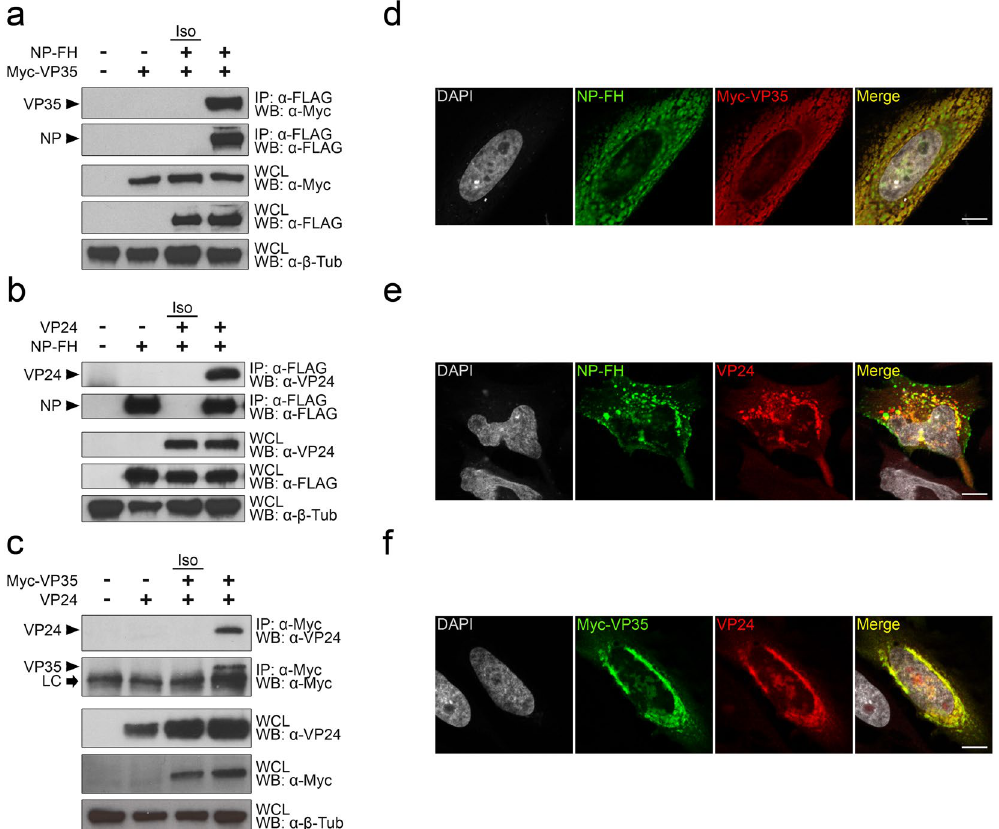
Figure 1. NP, VP35, and VP24 interact independently with each other. ( a – c ) HEK 293 cells were co-transfected with pCAGGS-NP-FH and pCAGGS-Myc-VP35 ( a ), pCAGGS-NP-FH and pCAGGS-VP24 ( b ), or pCAGGS- Myc-VP35 and pCAGGS-VP24 ( c ). Lysates were immunoprecipitated with mouse anti-FLAG ( a , b ), mouse anti-Myc ( c ), or isotype control (Iso; a , b ) antibodies, and immunoprecipitation (IP) and whole cell lysate (WCL) fractions were subjected to Western blot (WB) with mouse anti-FLAG, mouse anti-Myc, rabbit anti-VP24, and rabbit anti- β -tubulin antibodies. The precipitated proteins in the IP fraction are labeled with arrowheads, and the light chain (LC) of the mouse anti-Myc antibody is indicated with an arrow ( a , b ). IP/Western blot data are representative of at least three independent experiments. Western blots were cropped for presentation; full-length blots are available in Supplementary Fig. 6. ( d – f ) Hela cells were co-transfected with pCAGGS- NP-FH and pCAGGS-Myc-VP35 ( d ), pCAGGS-NP-FH and pCAGGS-VP24 ( e ), or pCAGGS-Myc-VP35 and pCAGGS-VP24 ( f ). Following fixation and permeabilization, cells were stained with rabbit anti-FLAG ( d ), mouse anti-FLAG ( e ), mouse anti-Myc ( d , f ), and/or rabbit anti-VP24 ( e , f ) antibodies prior to staining with AlexaFluor 488 goat anti-mouse and AlexaFluor 546 goat anti-rabbit secondary antibodies. Coverslips were mounted with ProLong Gold Antifade Mountant containing DAPI to visualize the nuclei. White scale bars represent 10